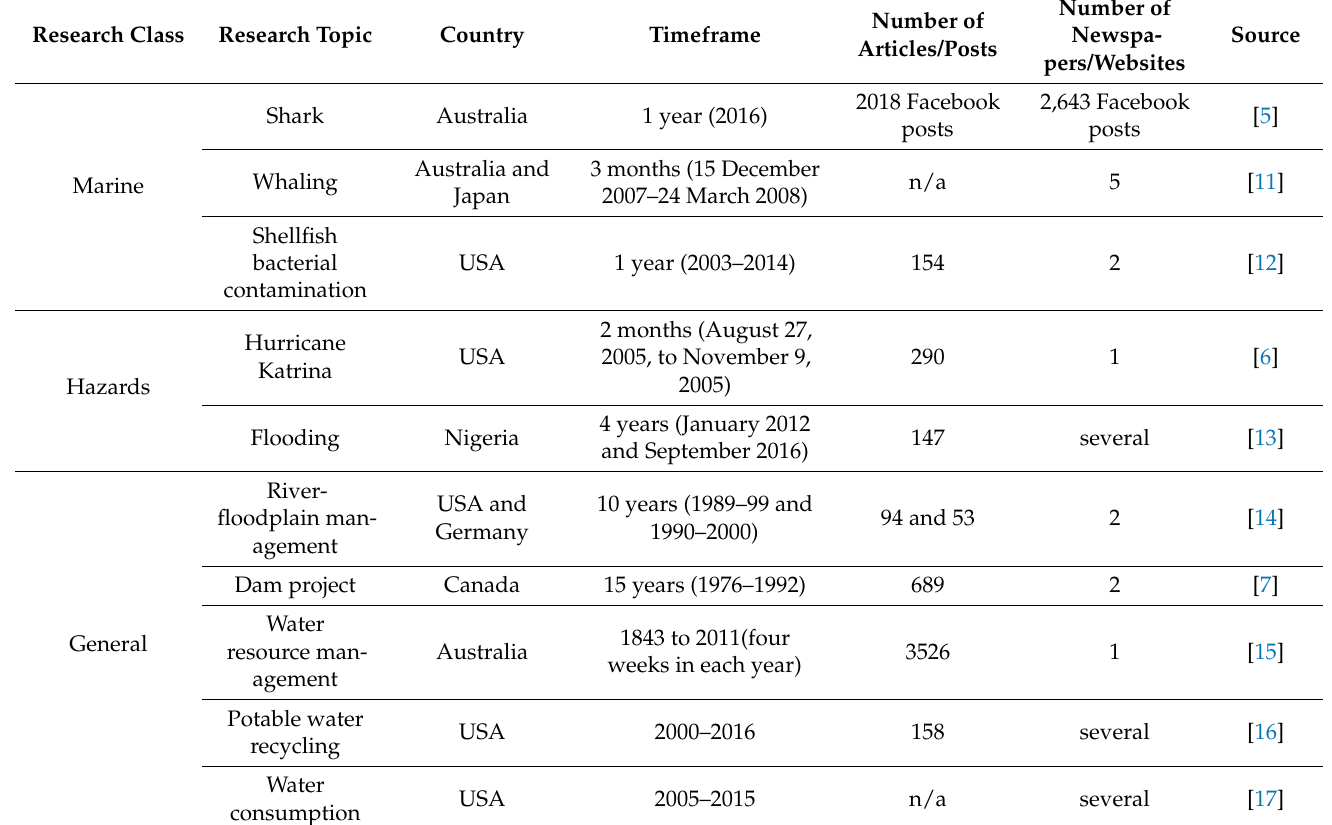
Table 1. Selected articles that have focused on water-related